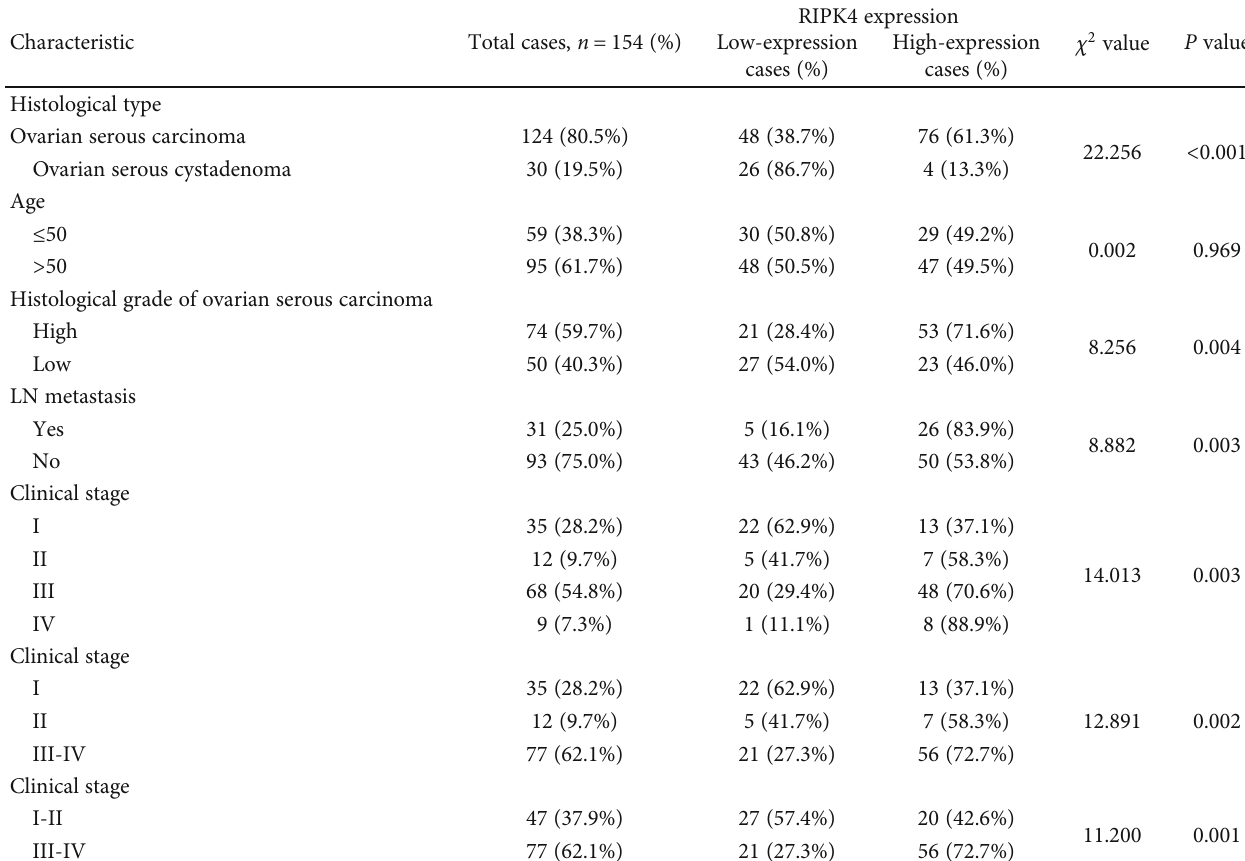
Table 2: Clinicopathological features and expression of RIPK4 in enrolled patients.